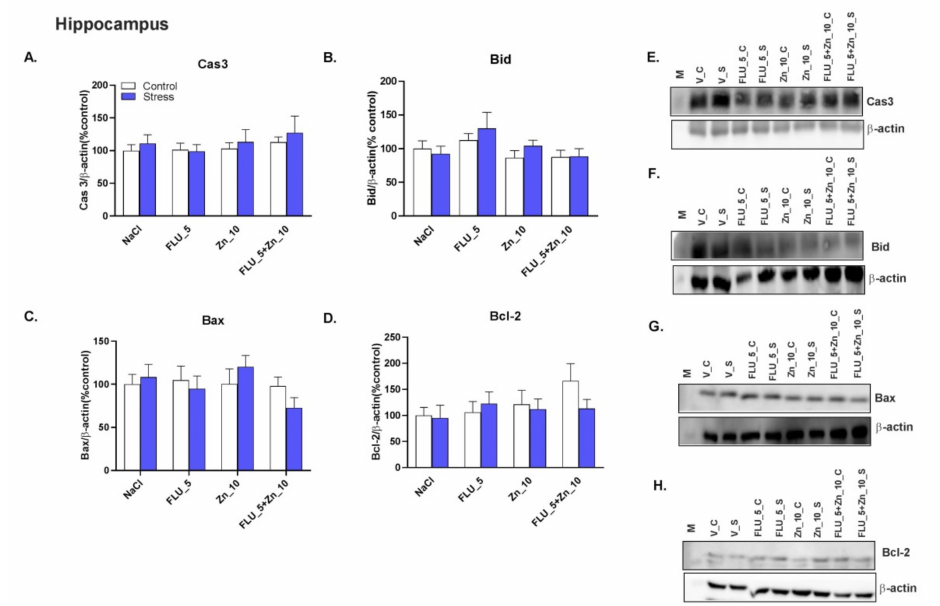
Figure 6. The effect of Zn supplementation and FLU treatment on caspase 3 (Cas3; A ), Bid ( B ), Bax ( C ), and Bcl-2 ( D ) proteins in the Hp of mice subjected to CRS. All data were analyzed by two-way ANOVA and Newman–Keuls multiple comparison test. Values are expressed as mean ± SEM; n = 4–6. ( E – H ) Representative Western